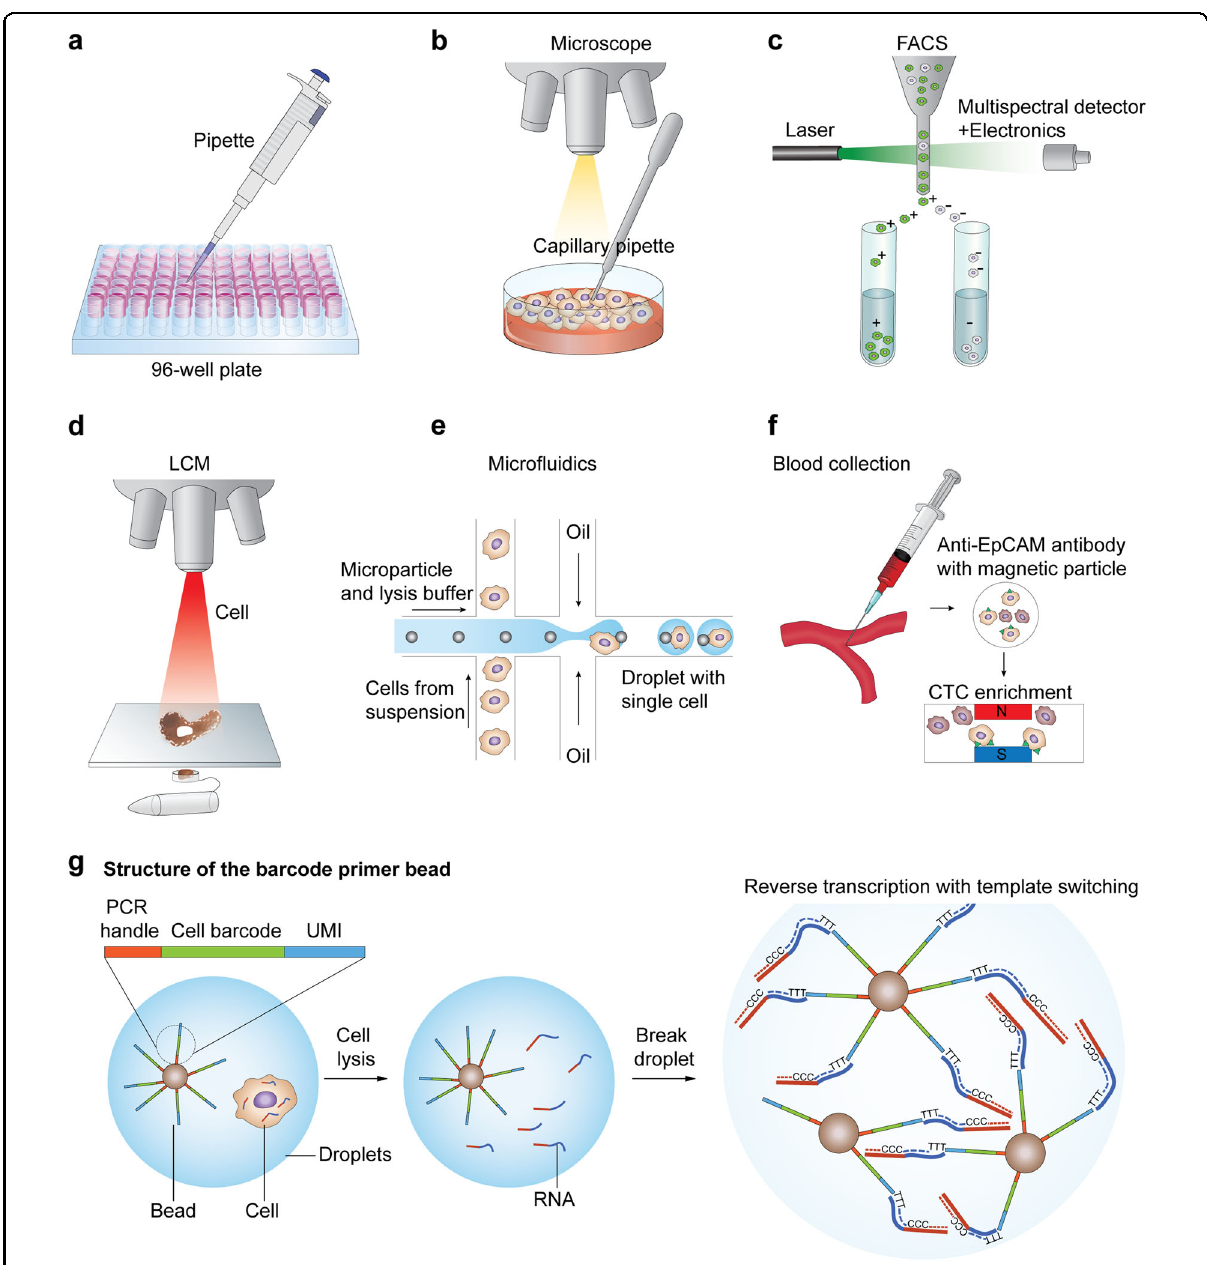
Fig. 1 Single-cell isolation and library preparation. a The limiting dilution method isolates individual cells, leveraging the statistical distribution of diluted cells. b Micromanipulation involves collecting single cells using microscope-guided capillary pipettes. c FACS isolates highly puri fi ed single cells by tagging cells with fl uorescent marker proteins. d Laser capture microdissection (LCM) utilizes a laser system aided by a computer system to isolate cells from solid samples. e Micro fl uidic technology for single-cell isolation requires nanoliter-sized volumes. An example of in-house microdroplet-based micro fl uidics (e.g., Drop-Seq). f The CellSearch system enumerates CTCs from patient blood samples by using a magnet conjugated with CTC binding antibodies. g A schematic example of droplet-based library generation. Libraries for scRNA-seq are typically generated via cell lysis, reverse transcription into fi rst-strand cDNA using uniquely barcoded beads, second-strand synthesis, and cDNA ampli fi